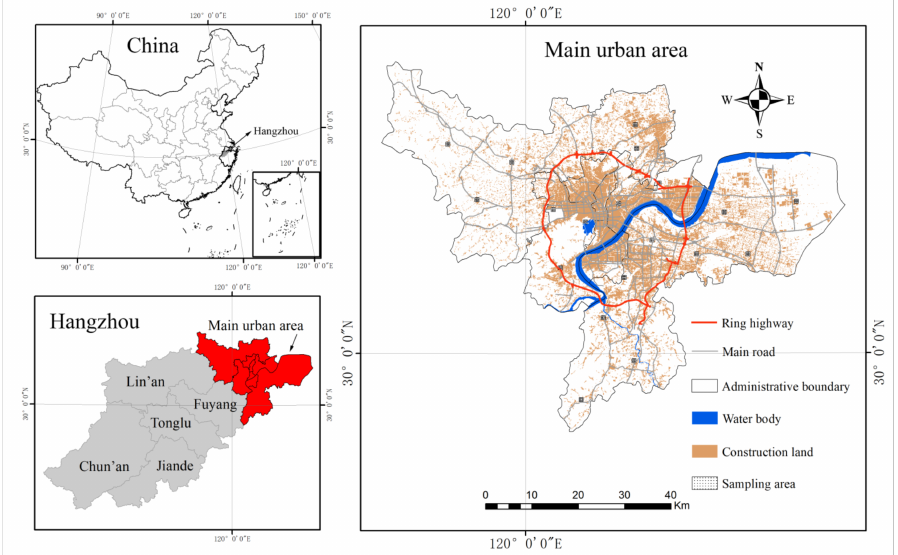
Figure 1. Location of the study area.